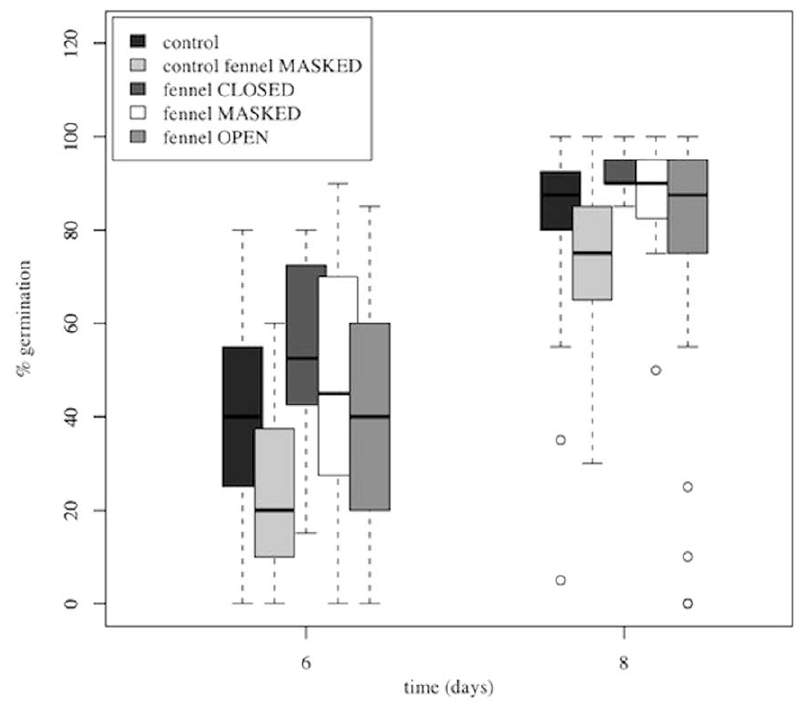
Figure 2. Germination of chilli seeds is affected by the mere presence of an adult fennel plant. Because very little germination had occurred at day 4 and almost all seeds had germinated at day 11, germination data at days 6 and 8 are presented and used for statistical analysis. The median, inter-quartile range and range are represented by the middle bar, the top and bottom of box and the whiskers respectively. Outliers laying more than 3 times the inter-quartile range from the median are represented by the small circles. * n is total number of seeds as appropriate for binomial analysis.